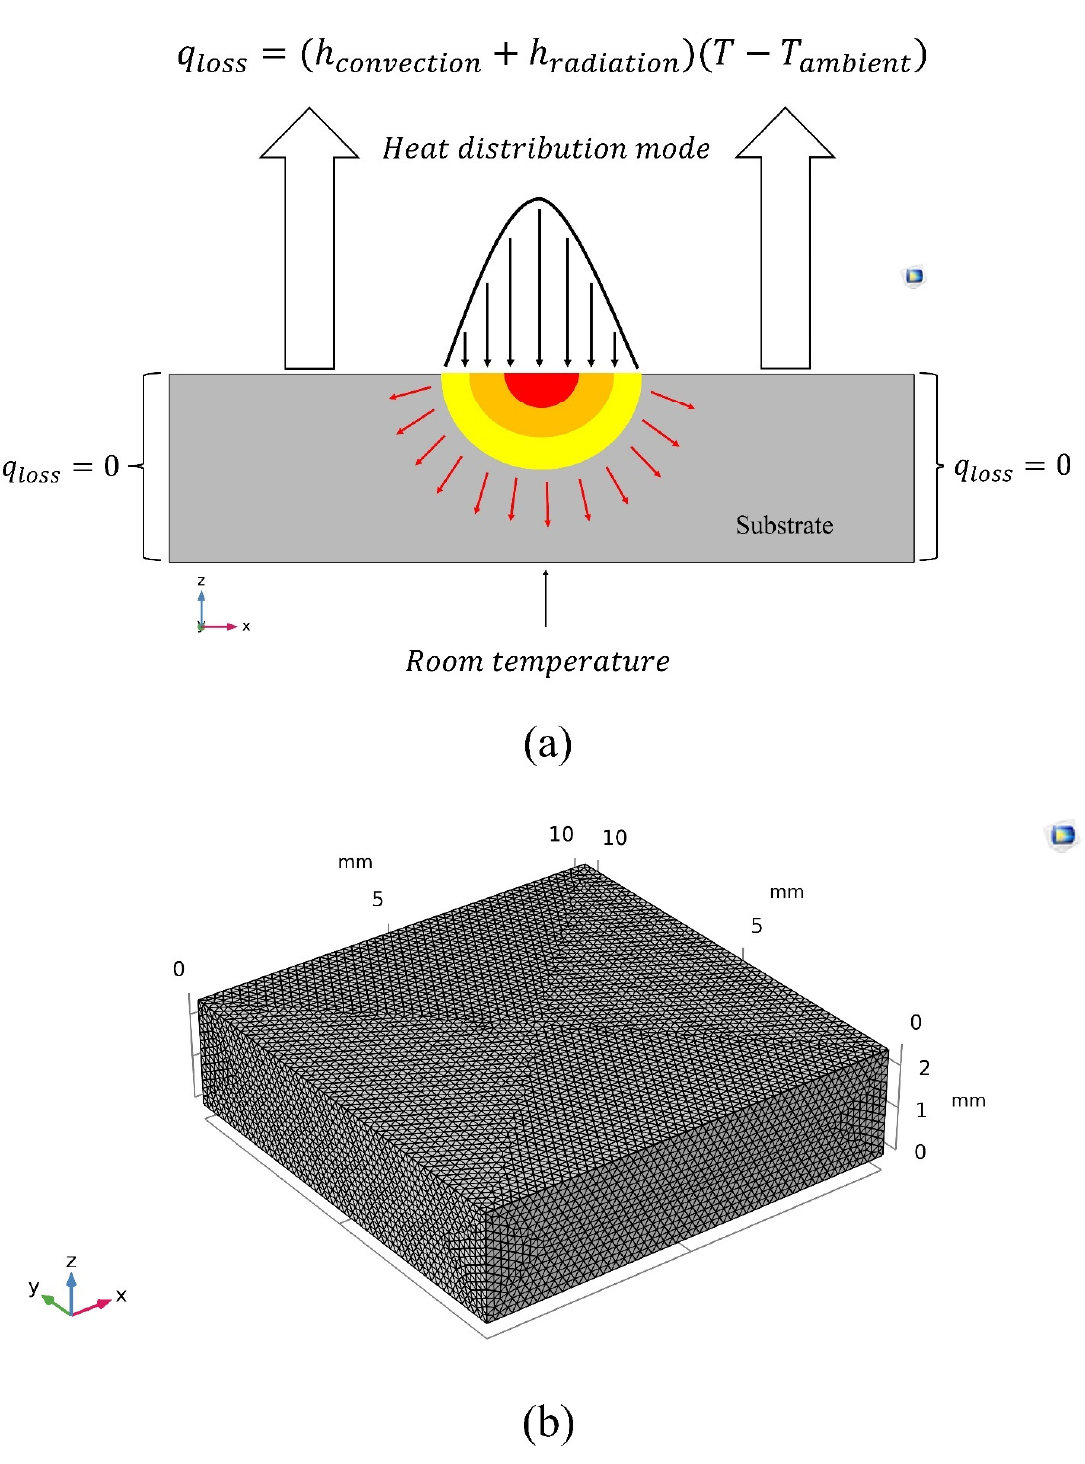
Figure 3. ( a ) Thermal model: (1) the distribution mode of laser heat source; (2) radiation and convection losses; (3) insulation of side walls; (4) the bottom part of the substrate remained at room temperature; ( b ) calculation domain used in the simulation.